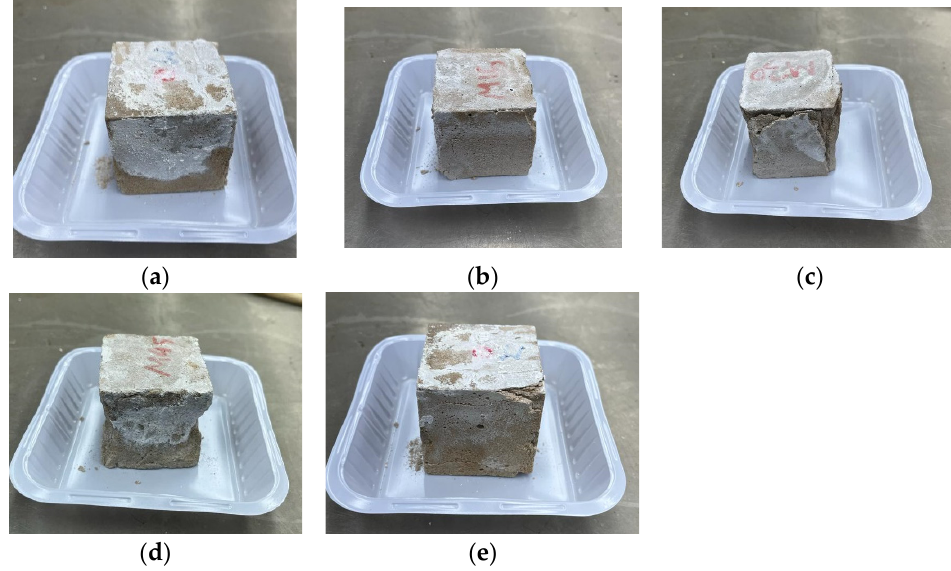
Figure 12. Efflorescence of hardened alkali-activated GBFS paste in contact with water. ( a ) 0%; ( b ) 15% DCP; ( c ) 30% DCP; ( d ) 45% DCP; and ( e ) 60% DCP.